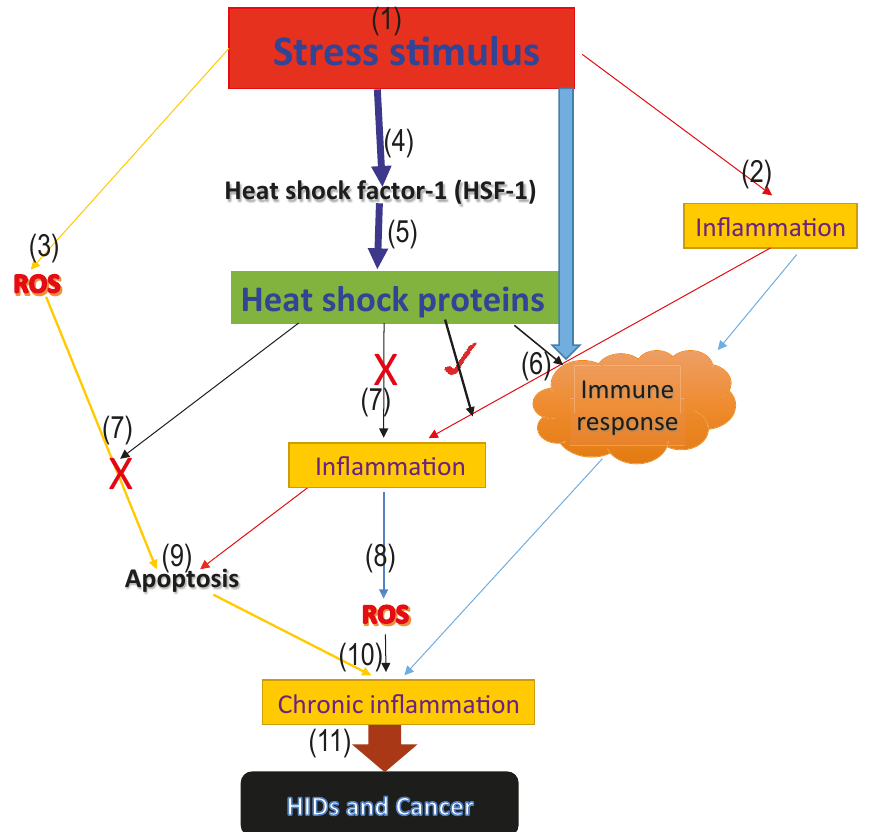
Figure 1. Model proposing the roles of heat shock proteins in HIDs and cancer. The above model represents the proposed roles that heat shock proteins play in human inflammatory diseases and